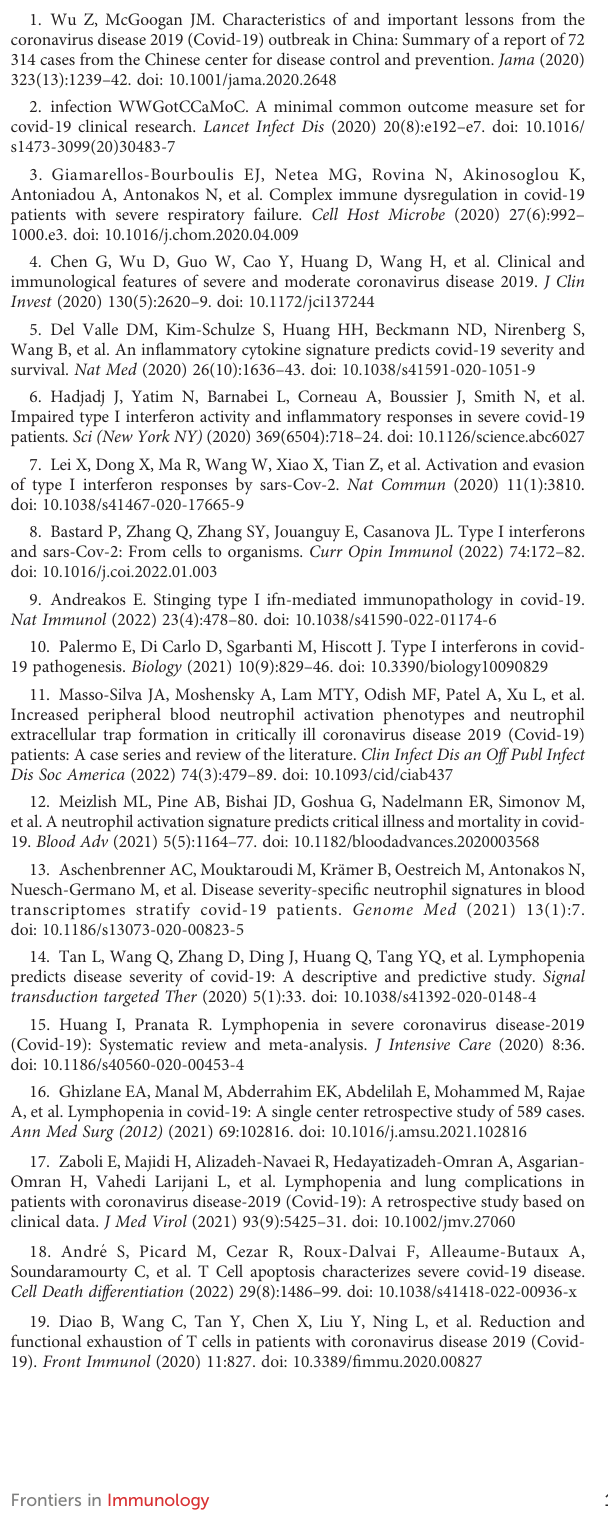
SUPPLEMENTARY DATA SHEET 10 limma_svrevsHC_200622.txt. SUPPLEMENTARY DATA SHEET 11